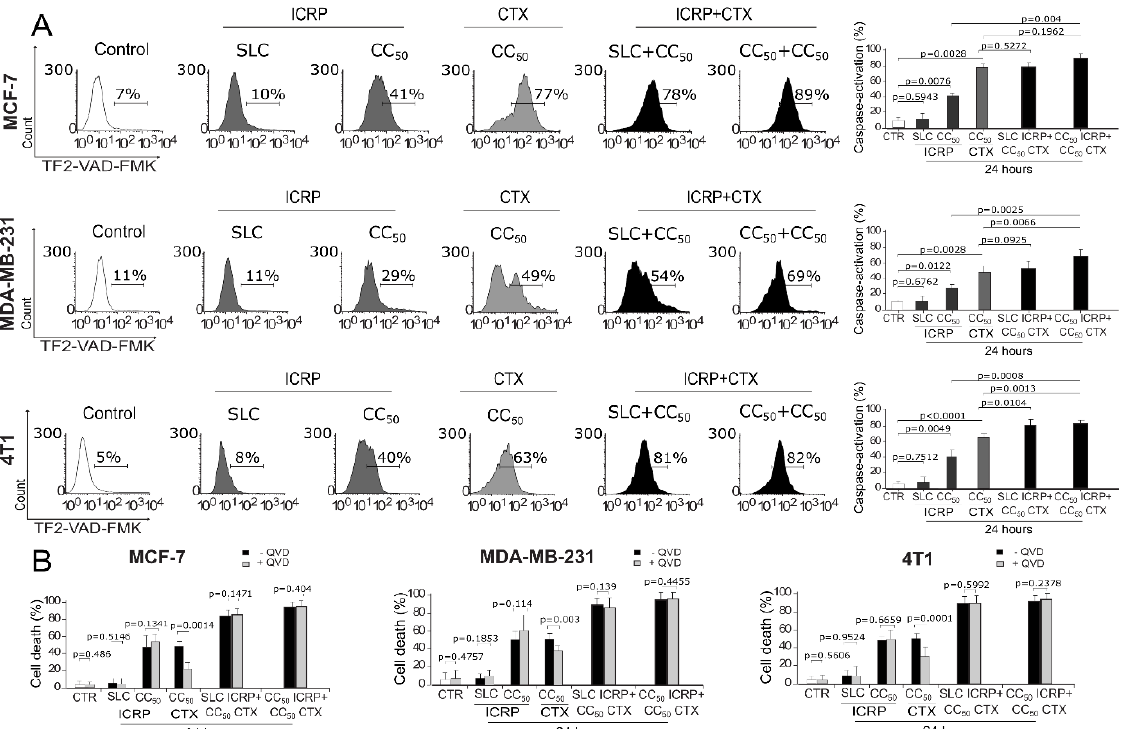
Figure 5: ICRP+CTX treatment induces cell death through a caspase-independent mechanism in breast cancer cells. Cells were treated with the combination of ICRP+CTX in two different ratios for 24 h and analyzed by flow cytometry in MCF-7, MDA-MB-231 and 4T1. A ) Representative histograms and graphs obtained from caspase activation analysis determined by TF2-VAD-FMK staining. B ) Cell death analyzed pre-treating MCF-7, MDA-MB-231 and 4T1, in presence or absence of caspase inhibitor (QVD, shown in light gray) using AnnV/PI staining. Graphs represent the mean value of at least three inde- pendent experiments performed in triplicate ±